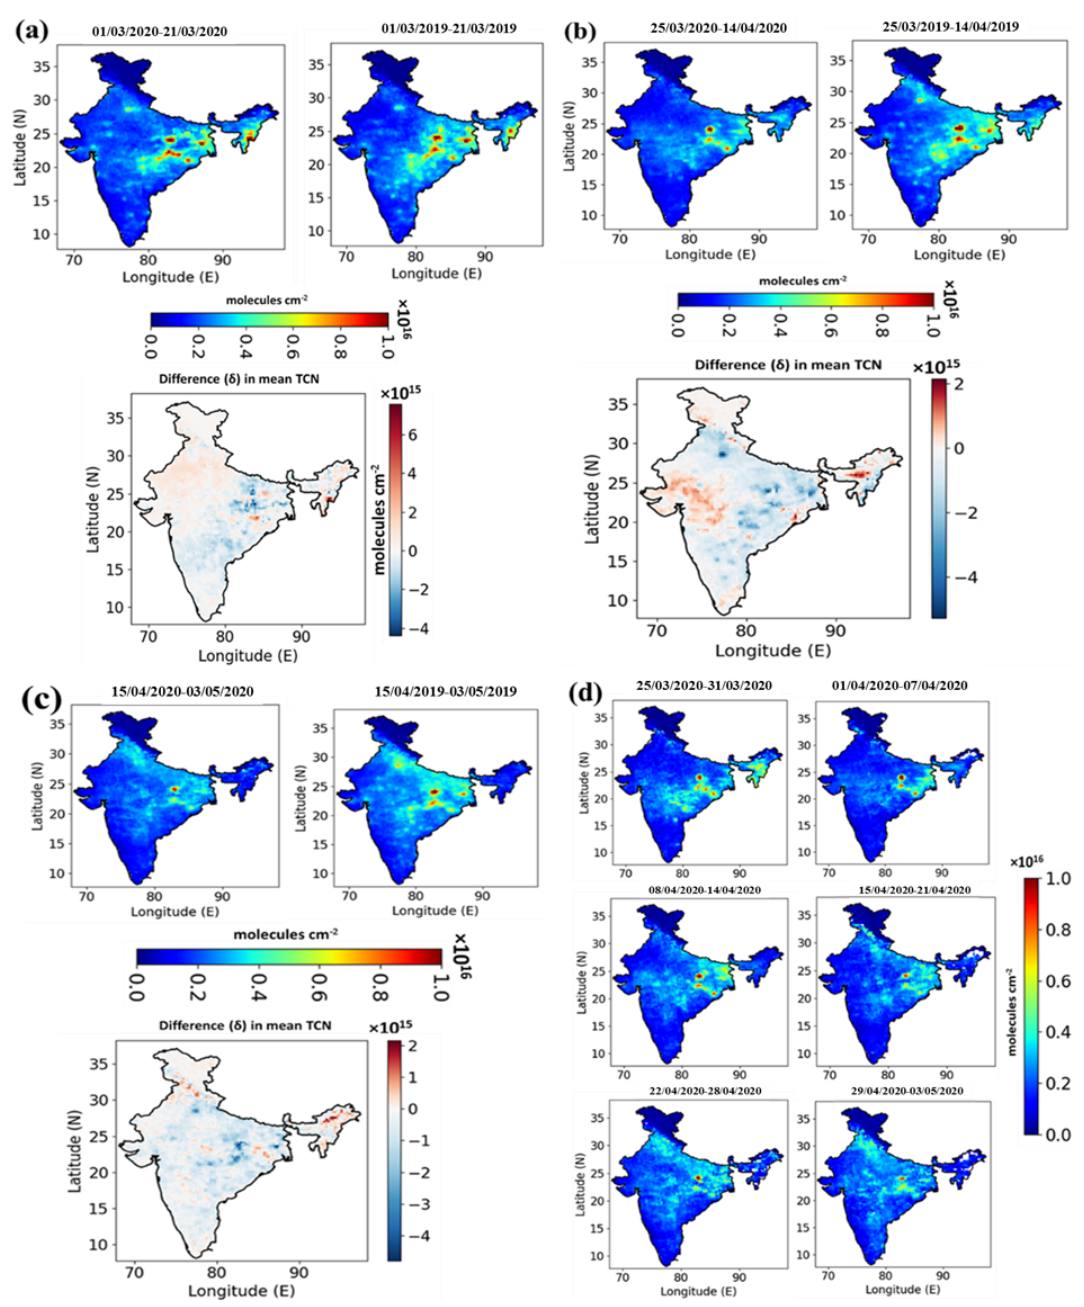
Figure 2. Time-averaged TROPOMI TCN concentration and its difference maps between 2020 and 2019 during (a) pre-LD, (b) phase I lockdown, and (c) phase II lockdown. (d) Weekly mean TCN variation starting from 25 March to 3 May